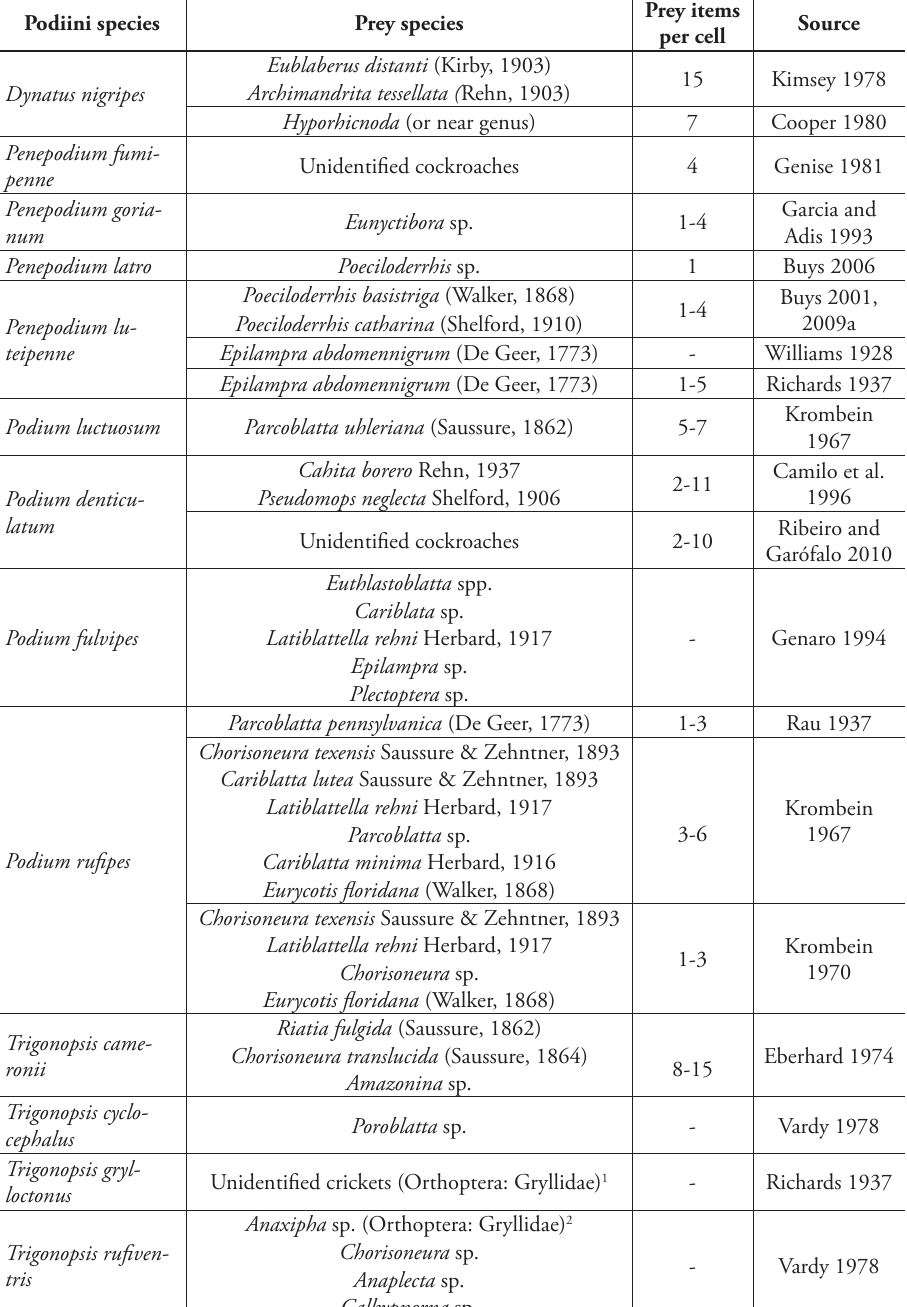
table 2. Summary of prey species and number of prey items per nest in species of the tribe